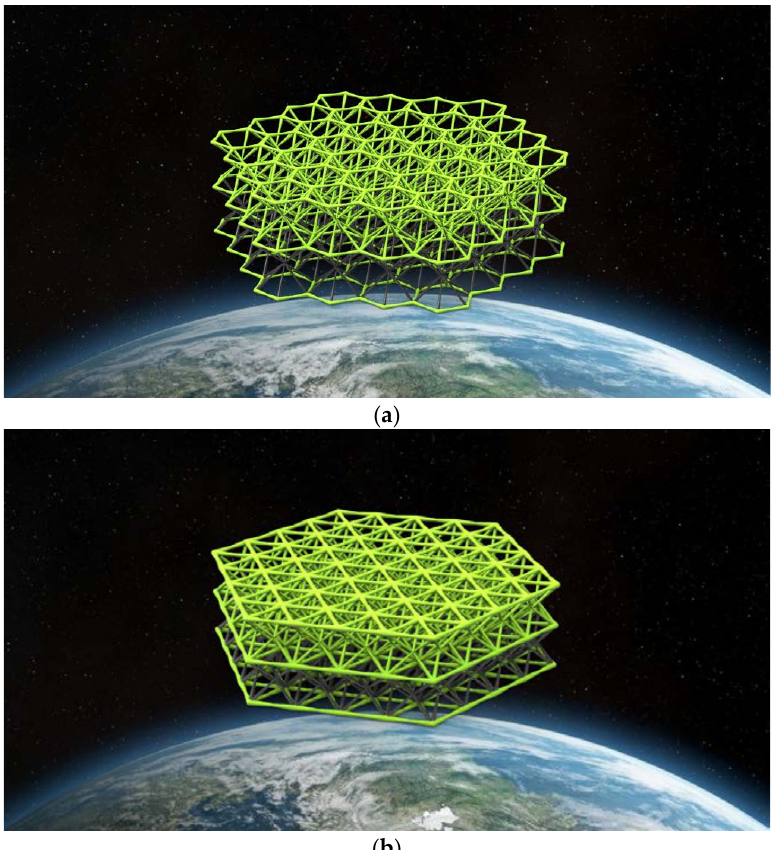
Figure 5. Schematic illustration of bi-material dual-layer hourglass under the circular array; ( a ) hexagon